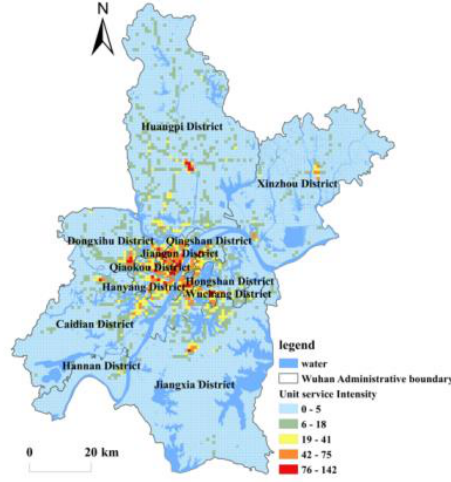
Figure 3 Public transport service configuration distribution